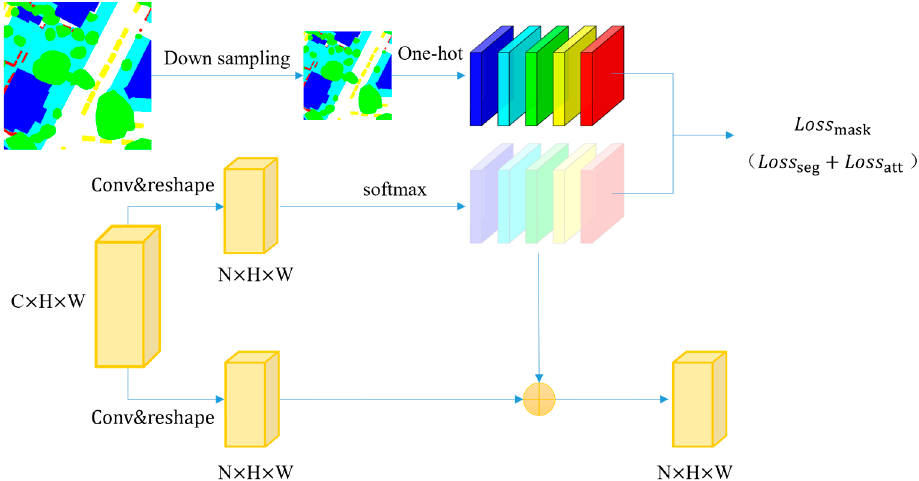
Figure 5. Architecture of Label Attention Module.